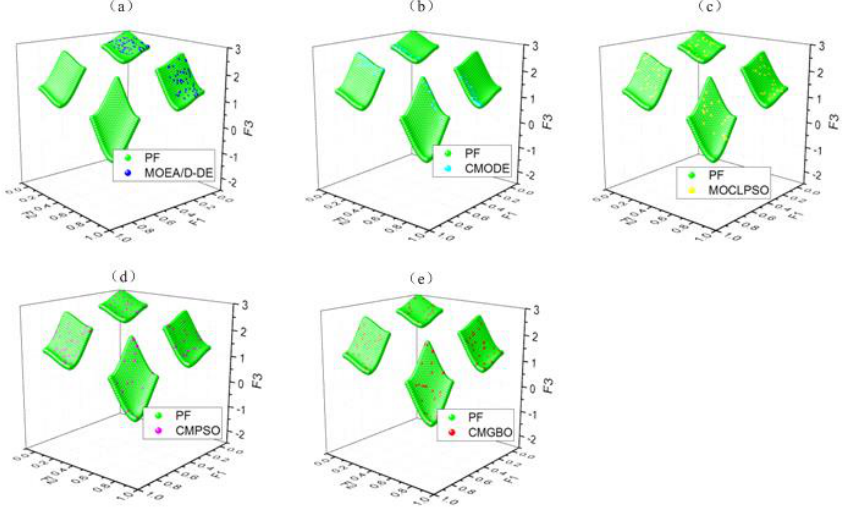
Figure 7. Non − dominated solutions of DTLZ7: ( a ) MOEA/D − DE; ( b ) CMODE; ( c ) MOCLPSO; ( d ) CMPSO; ( e ) CMGBO.